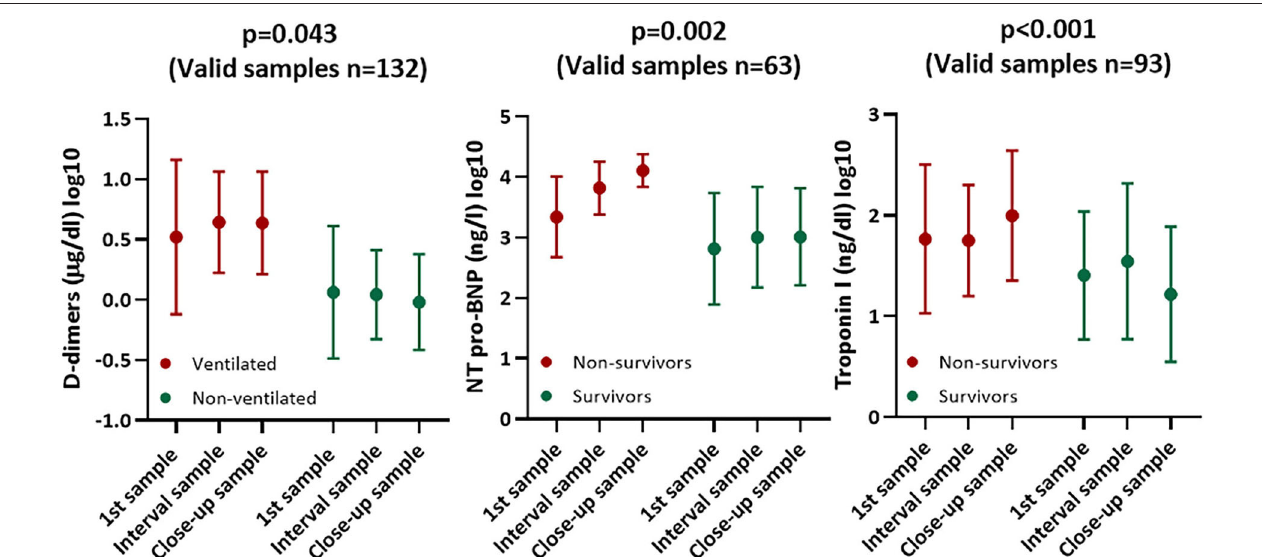
FIGURE 2 | Diagrams (mean ± SD) showing course of cardiac and thrombotic biomarkers stratified according to survival and mechanical ventilation.